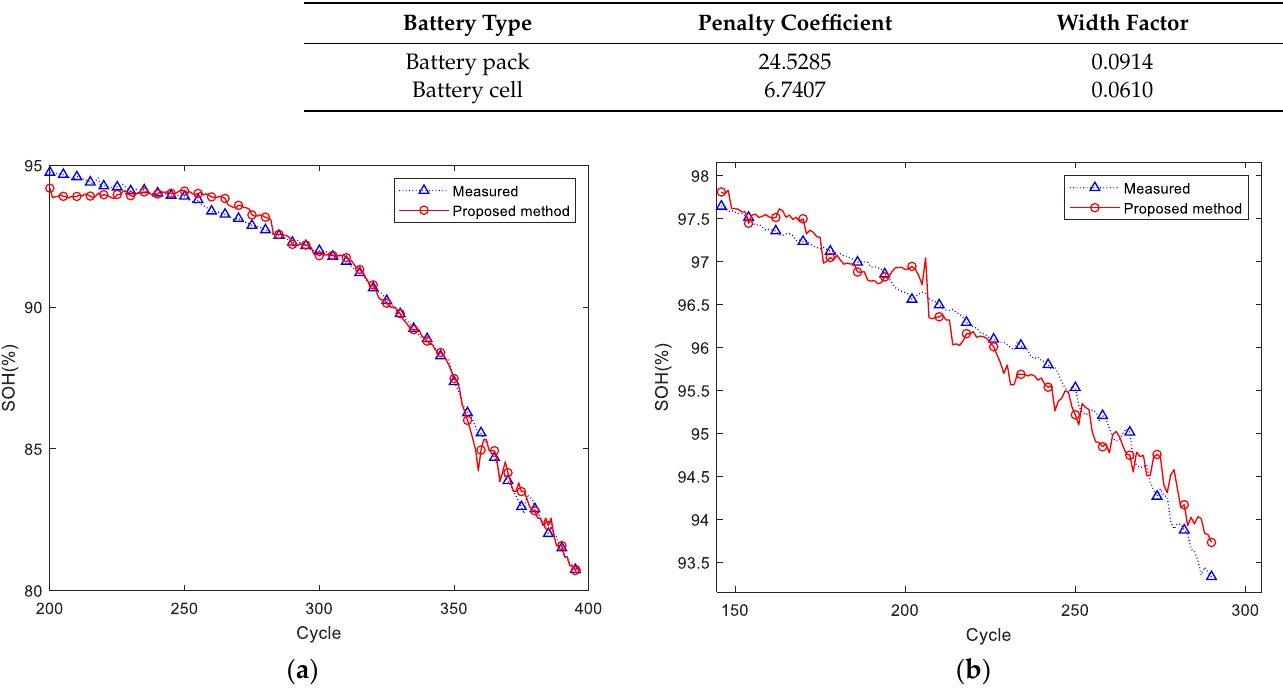
Table 1. The optimized penalty coefficient and width factor of SVM in the proposed method.